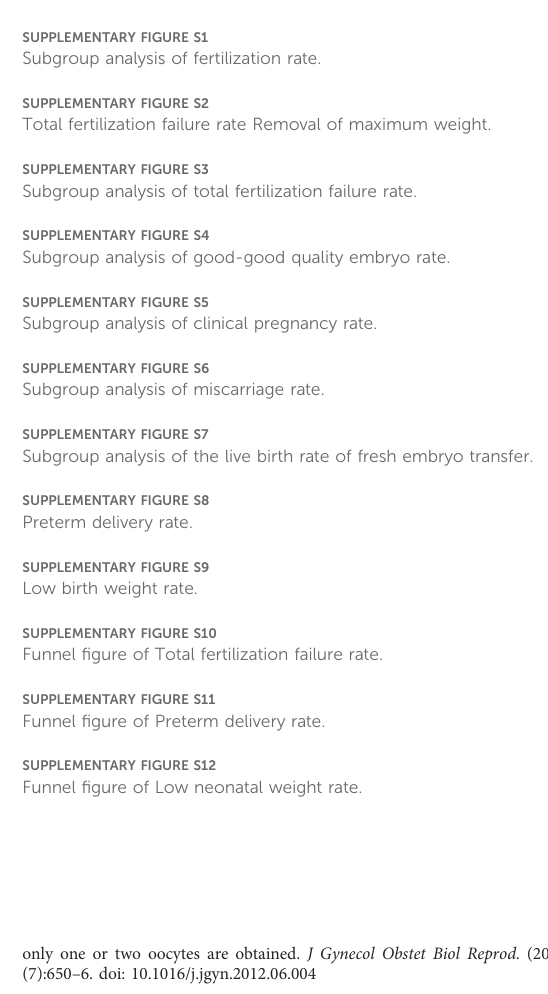
SUPPLEMENTARY FIGURE S1 Subgroup analysis of fertilization rate. SUPPLEMENTARY FIGURE S2 Total fertilization failure rate Removal of maximum weight. SUPPLEMENTARY FIGURE S3 Subgroup analysis of total fertilization failure rate. SUPPLEMENTARY FIGURE S4 Subgroup analysis of good-good quality embryo rate. SUPPLEMENTARY FIGURE S5 Subgroup analysis of clinical pregnancy rate. SUPPLEMENTARY FIGURE S6 Subgroup analysis of miscarriage rate. SUPPLEMENTARY FIGURE S7 Subgroup analysis of the live birth rate of fresh embryo transfer. SUPPLEMENTARY FIGURE S8 Preterm delivery rate. SUPPLEMENTARY FIGURE S9 Low birth weight rate. SUPPLEMENTARY FIGURE S10 Funnel fi gure of Total fertilization failure rate. SUPPLEMENTARY FIGURE S11 Funnel fi gure of Preterm delivery rate. SUPPLEMENTARY FIGURE S12 Funnel fi gure of Low neonatal weight